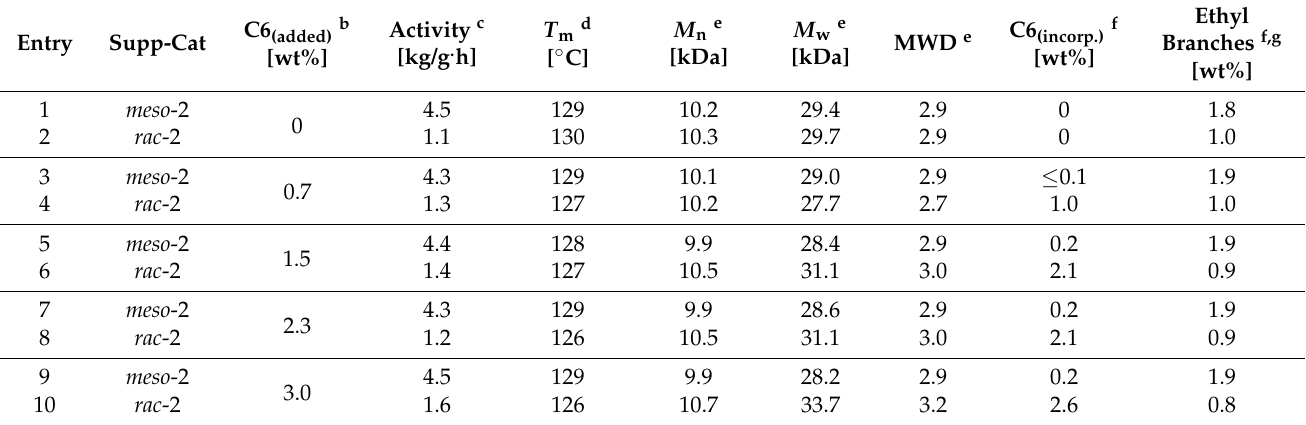
Table 2. Copolymerization of ethylene and 1-hexene with heterogeneous supp- meso -2 and supp- rac -2 a